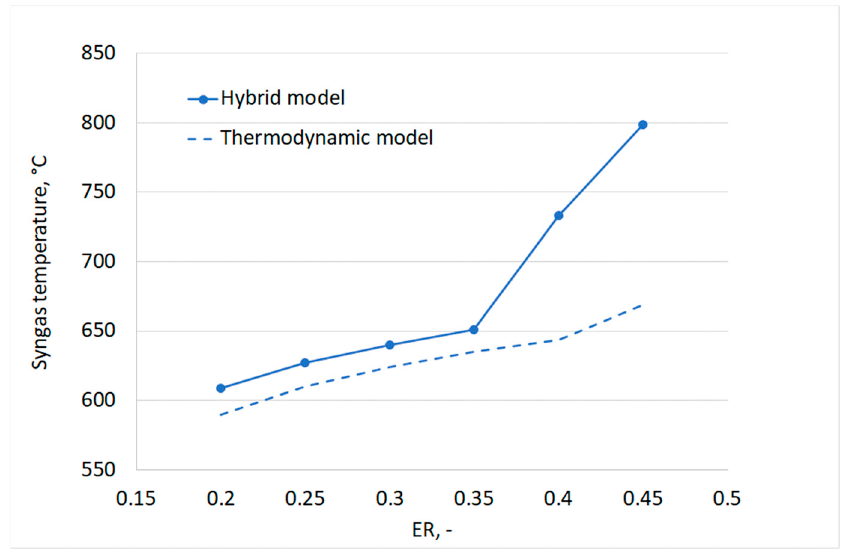
Figure 13. Comparison between new hybrid approach and thermodynamic model results: relative weights of CO, CO 2 , CH 4 , and H 2.